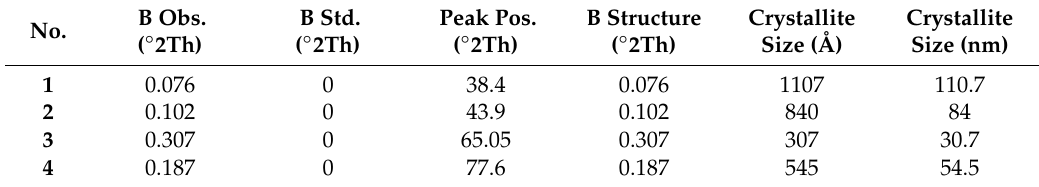
Figure 7. XPS spectra of the taurine-capped AuNPs (with λ max 515 and λ max 545 nm) and the bulk compound taurine as shown in ( A ). The inset graphs in ( a – d ) show the deconvolution of the Au4f, C1s, N1s, and O1s spectra, respectively. ( B ) XRD pattern of the taurine-capped gold nanospheres index at (111), (200), (220) and (311), depicting their crystalline nature for gold metal. Table 1. Structure parameters of the taurine-capped AuNPs with λ max 515 nm.